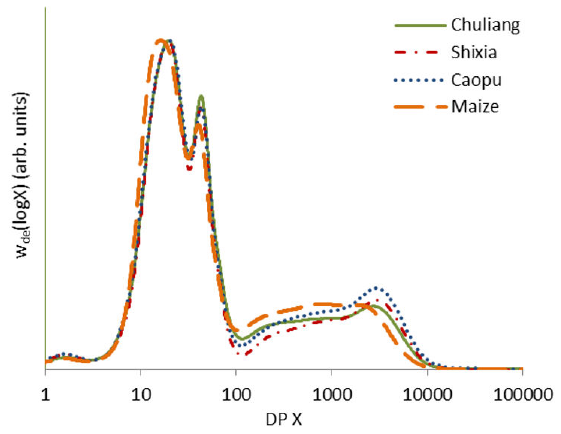
Figure 3. Chain-length distributions of longan seed starch compared with normal maize starch.